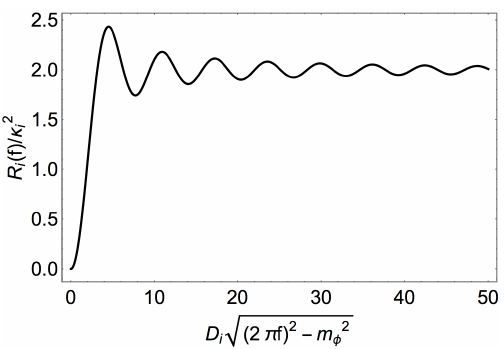
= 2 [ 1 − sinc ( kD )] for a pair of identical atomic i i